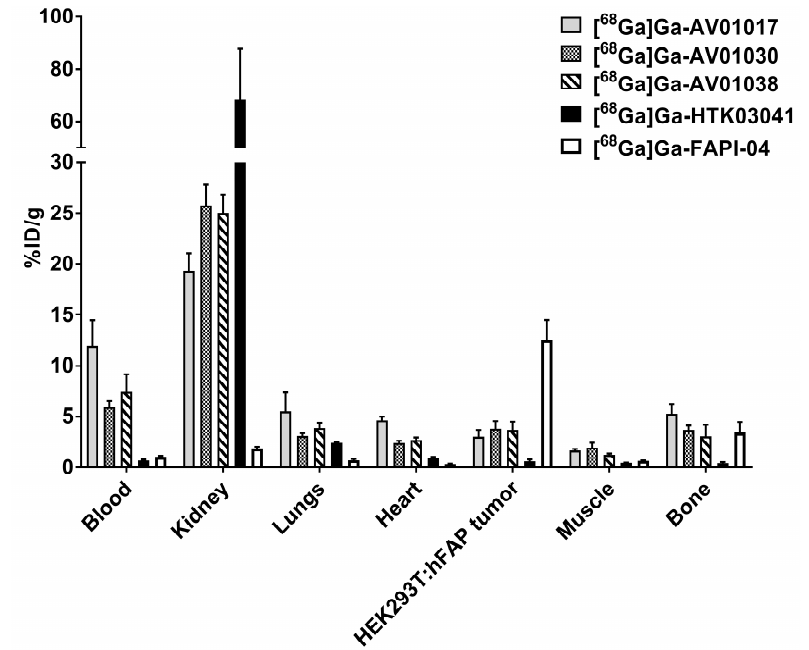
Figure 6. Biodistribution of [ 68 Ga]Ga-AV01017, [ 68 Ga]Ga-AV01030, [ 68 Ga]Ga-AV01038, [ 68 Ga]Ga- HTK03041, and [ 68 Ga]Ga-FAPI-04 in HEK293T:hFAP tumor-bearing